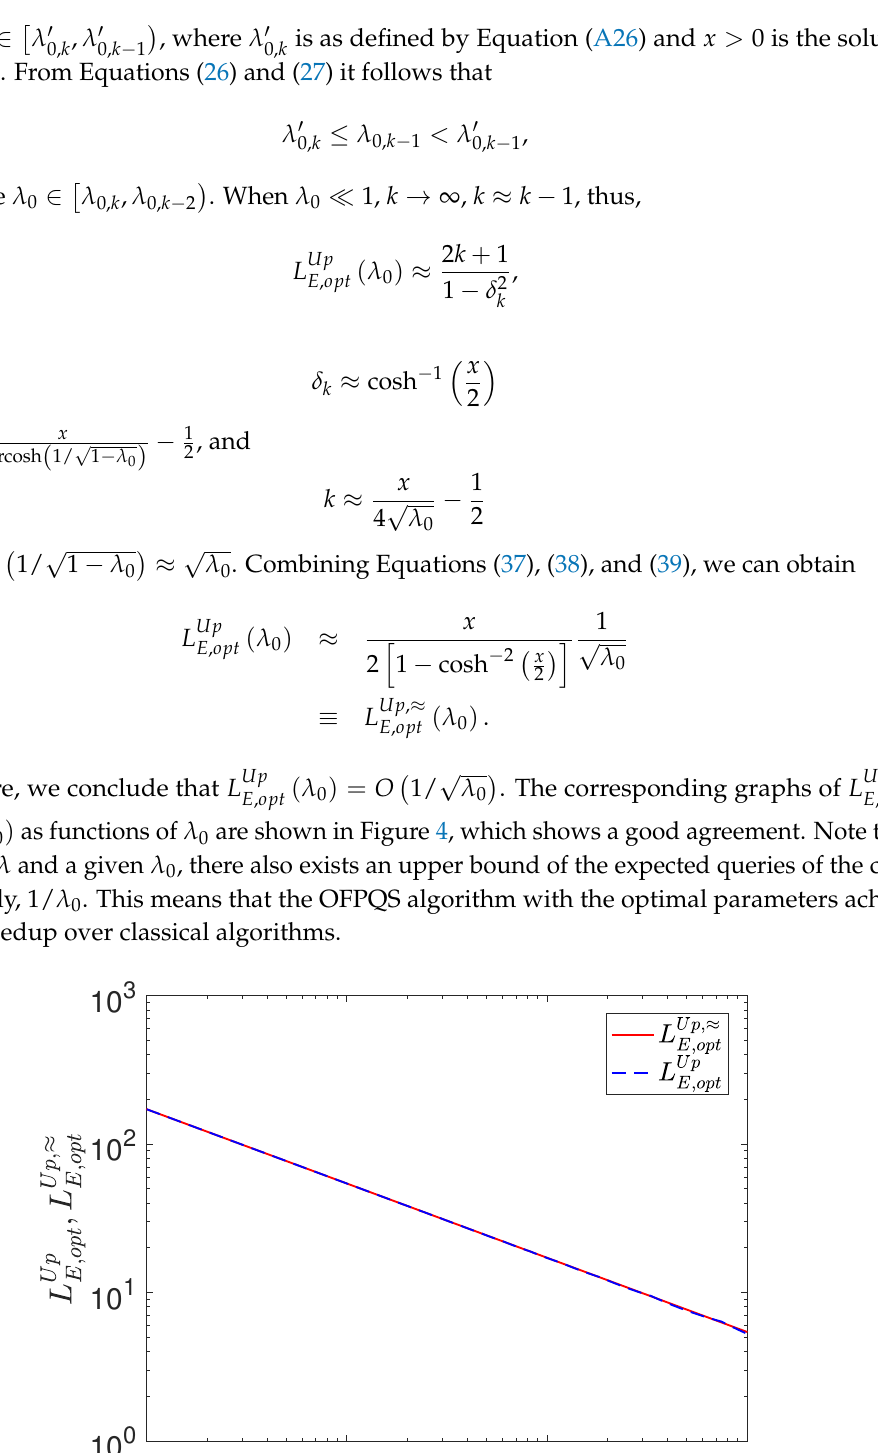
Figure 4. (Color online.) The optimal upper bound of expected queries L Up approximation L Up , target items. The blue dashed and red solid curves represent L Up